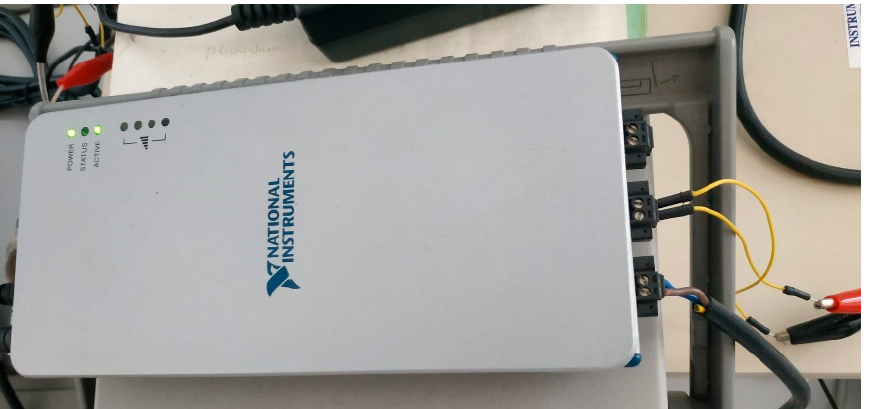
Figure 3. The NI 9225 card inside the chassis cDAQ-9191 (1-Slot, Ethernet and 802.11 Wi-Fi compact DAQ chassis) with wiring connections: Yellow wires (“crocodile”-type probes) correspond to the GPS-PPS signal while the black-covered wires brings the network voltage signal directly by connecting to it with a plug.